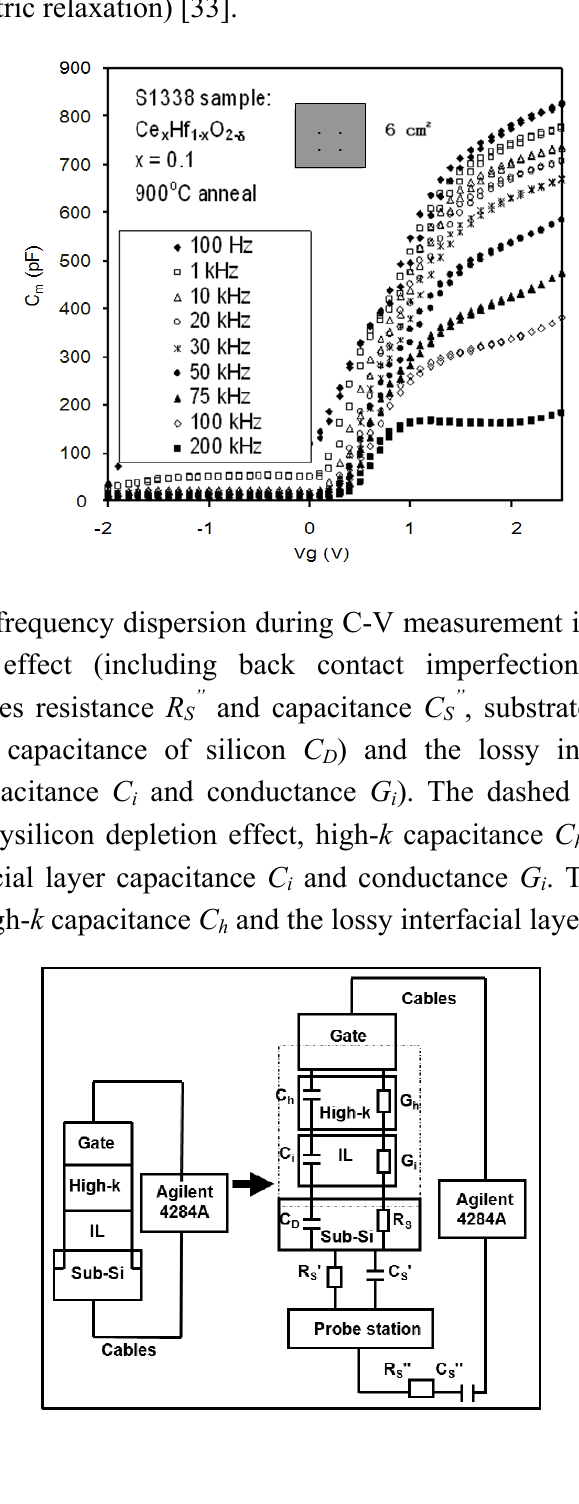
Figure 5. C-V curves from a Ce Hf O thin film at different frequencies (from 100 Hz x 1 − x 2 −δ to 200 kHz). Frequency dispersion could still be observed regardless of the interfacial layer effect of MOS structures and parasitic effects (caused by substrate resistance, back contact imperfection and cables). This kind of dispersion was caused by the frequency dependence of the k -value (dielectric relaxation) [33].